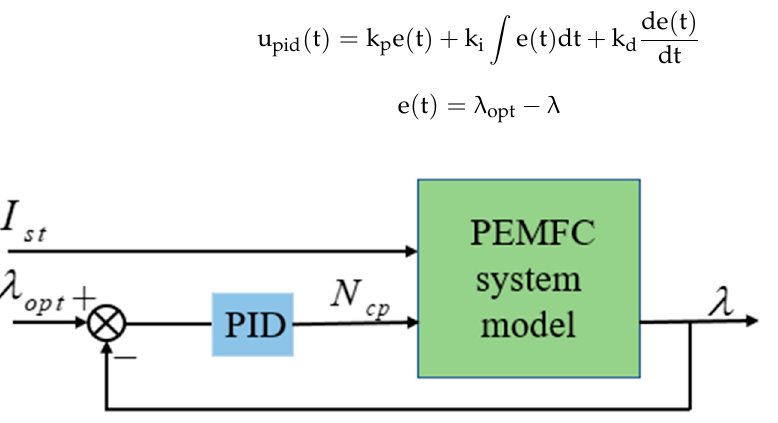
Figure 6. Structure of PID controller.